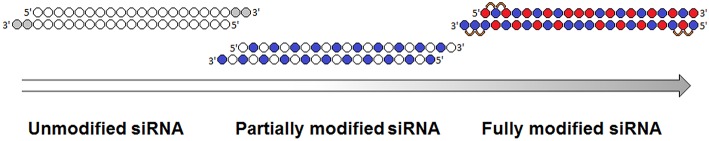
Evolution of siRNA chemical modification patterns. Chemical modifications are indicated in gray (deoxyribonucleotides), blue (2′O-Me), red (2′F), and orange (PS) [adapted from Khvorova and Watts (2017)].